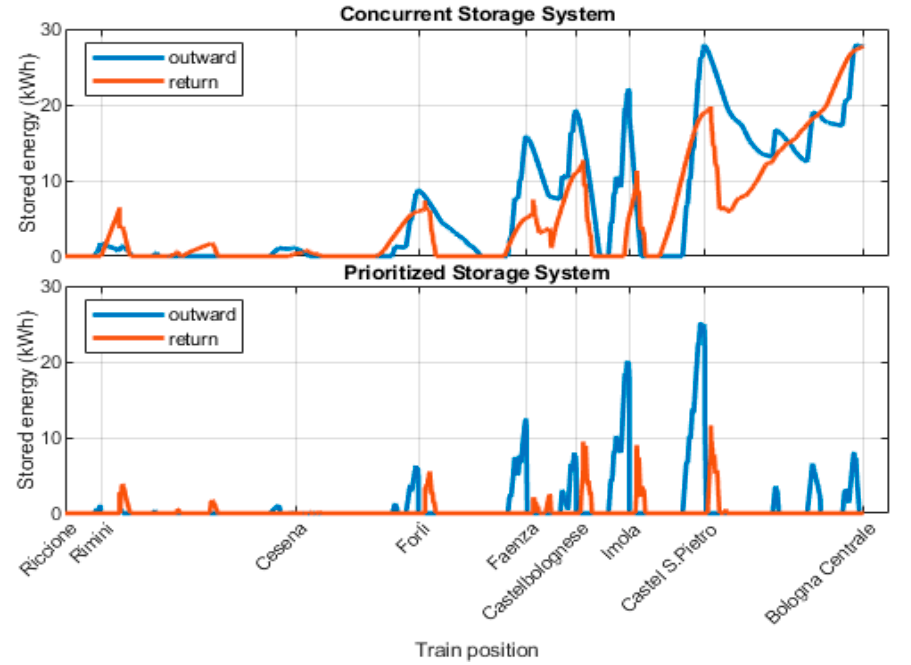
Figure 13. Amount of energy in the ESS in the substation of Imola during the round trip.